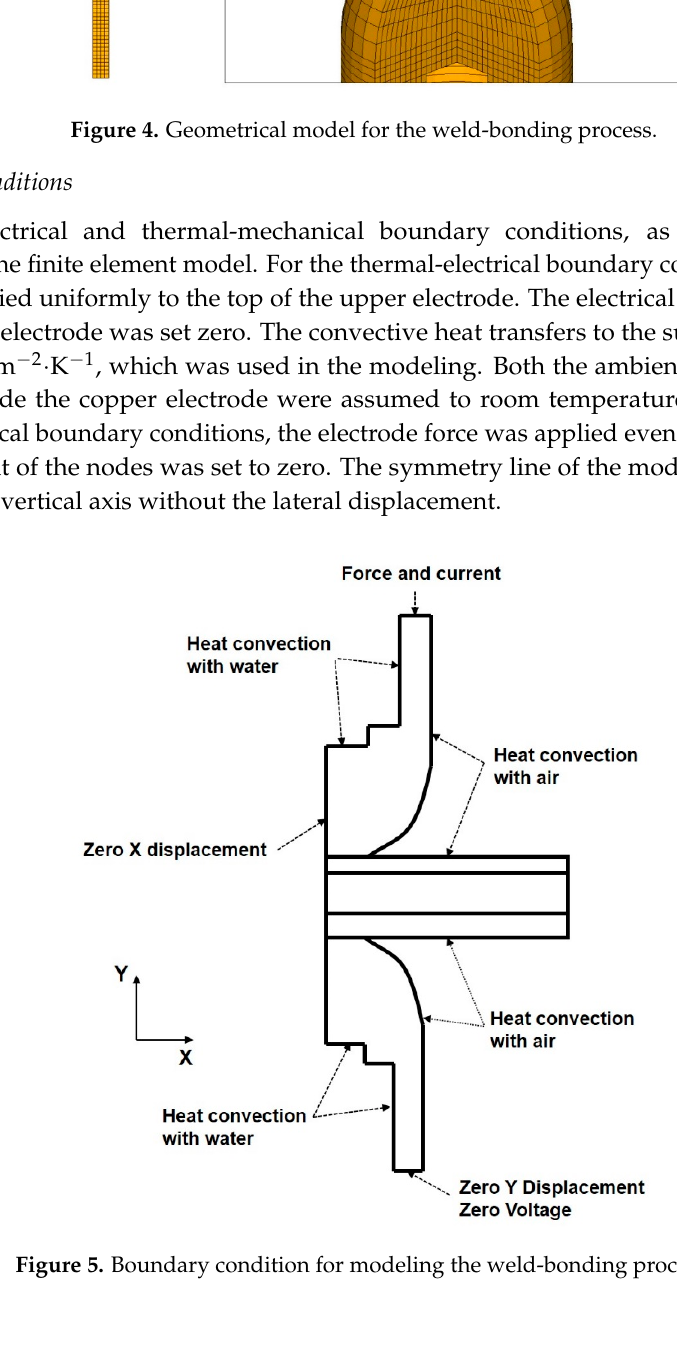
Figure 4. Geometrical model for the weld-bonding process.